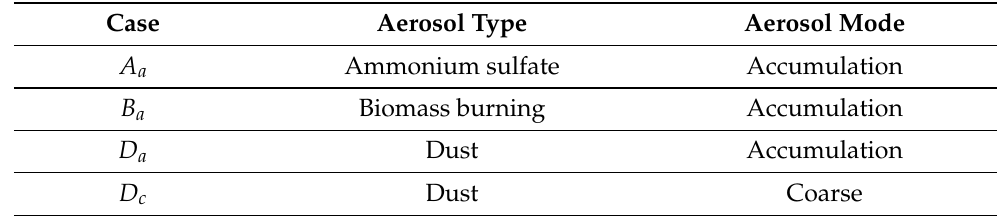
Table 5. LARSS monomodal implemented